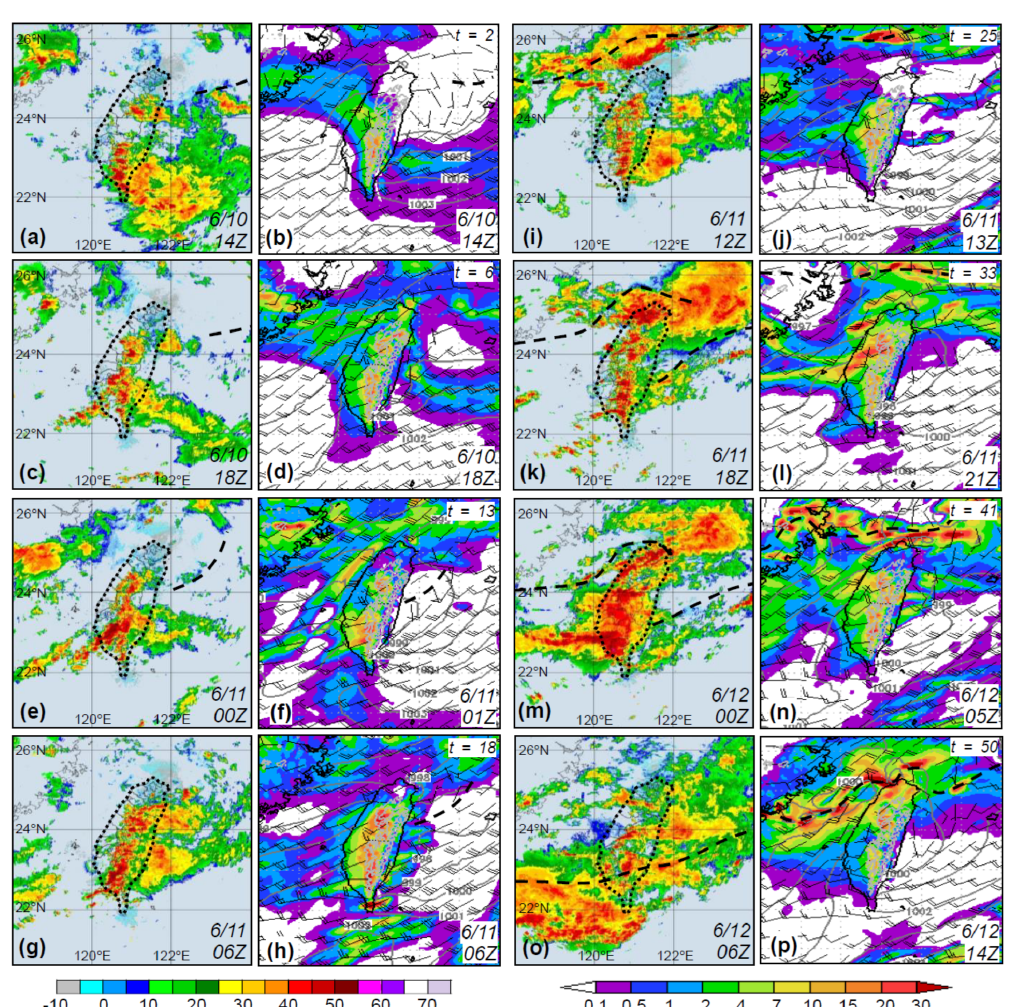
Figure 9. As in Fig. 8, but showing (a, c, e, g, i, k, m, o) radar reflectivity composite (dBZ) at (a) 14:00UTC 10 June and every 6h from (c) 18:00UTC 10 June to (o) 06:00UTC 12 June 2012 and (b, d, f, h, j, l, n, p) the CReSS forecast, starting from 12:00UTC 10 June 2012, of sea-level pressure (hPa), surface wind (kn), and hourly rainfall (mm) valid at the time or within up to 8h (towards the end) of the radar composite (as labeled).